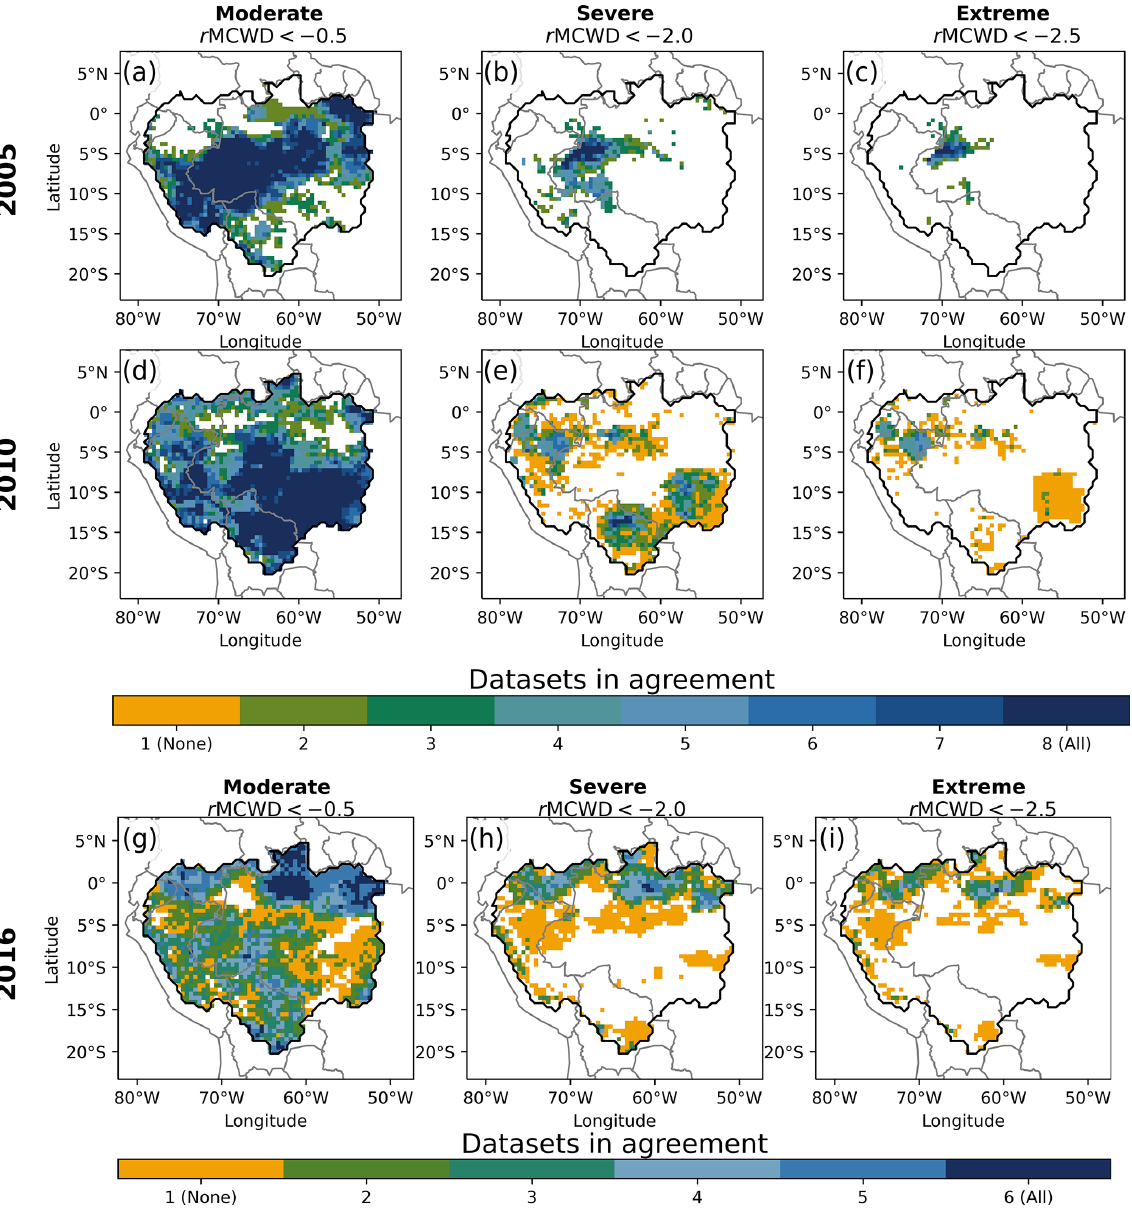
Figure 3. Agreement of precipitation datasets on drought area as identified by relative MCWD anomalies. In columns, different levels of drought severity are displayed, and rows show the different drought years: (a–c) 2005, (d–f) 2010 and (g–i) 2016. The colours indicate the number of datasets that agree on a specific drought level in a given pixel. Drought severity levels are defined as moderate (rMCWD < − 0 . 5), severe (rMCWD < − 2 . 0) and extreme (rMCWD < − 2 . 5). Orange pixels indicate areas where only one dataset shows the respective drought stress (no agreement is labelled “None”). White pixels represent areas where no dataset shows any drought signal. Note that in panels (a) – (f) , TRMM 6 and GSWP3 were excluded, as they were either very similar to their successor (TRMM 7) or due to a similar reanalysis procedure (WATCH WFDEI). In panels (g) – (i) , only six datasets were included which cover the full time period until